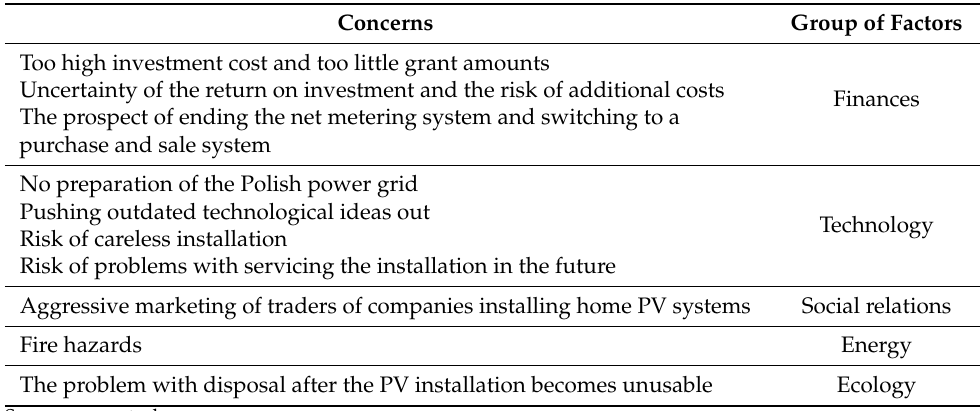
Table 7. Reasons for skepticism towards PV micro-installations ( n =